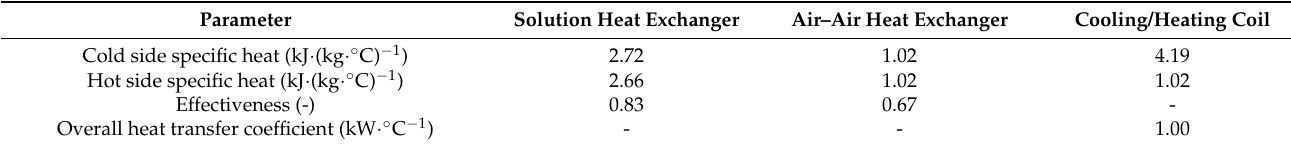
Table 4. Specifications of the heat